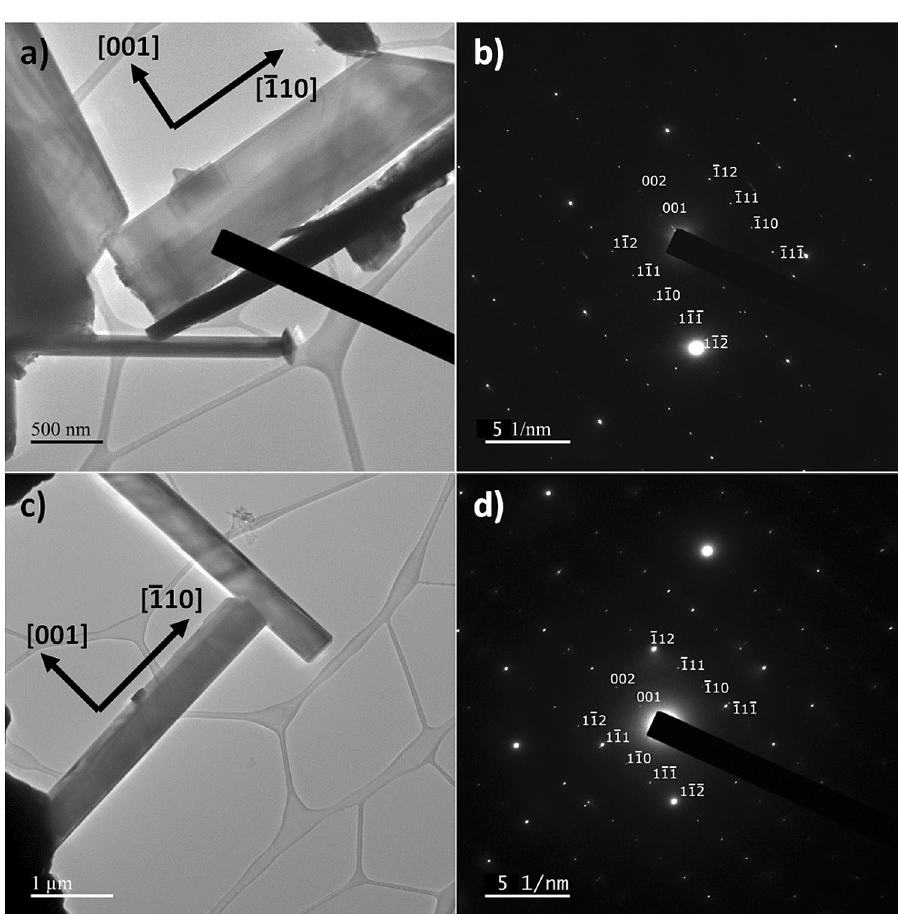
Figure 10. Indexed SAED pattern for ( a , b ) with Ag catalyst, ( c , d ) without Ag